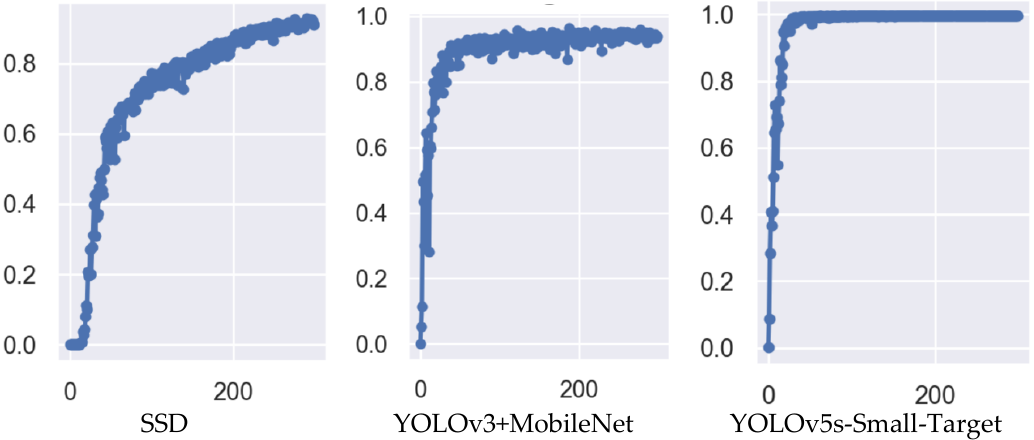
Figure 21. Comparison of mean average precision mAP for defect detection with different detection algorithms.